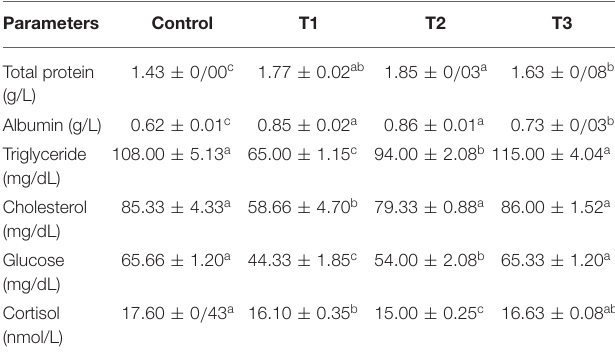
TABLE 4 | Biochemical parameters of rainbow trout fed diets incorporated with different levels of zero (Control), 0.5% (T1), 1% (T2) and 2% (T3) of a mixture of herbs ( Mentha longifolia , Thymus carmanicus , Trachyspermum copticum ) for 45 days.